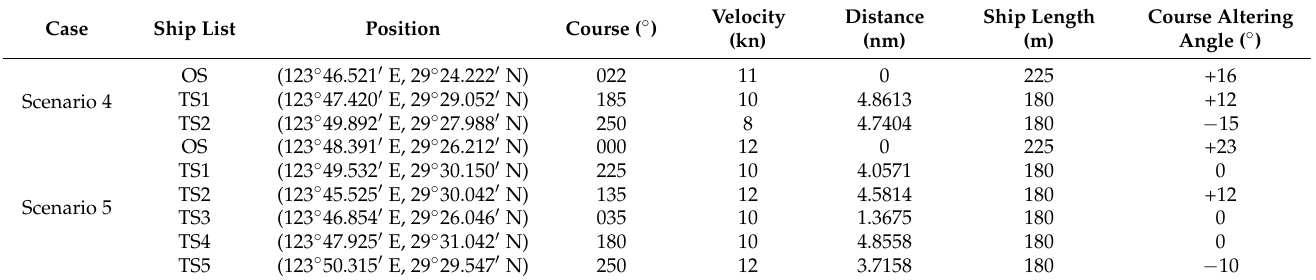
Table 2. Settings of multi-ship